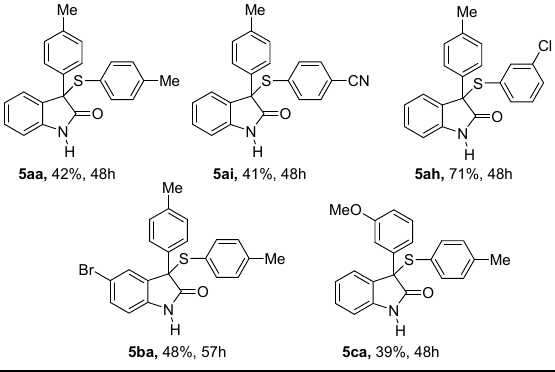
Figure 4. Thiolation of 3-aryloxindoles with sulfonyl chlorides in the presence of PPh 3 . a